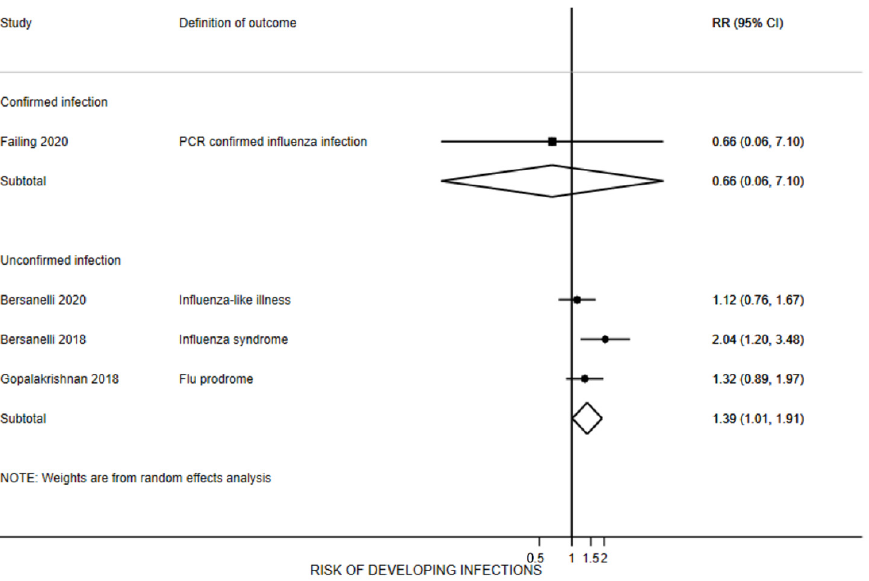
Figure 5. Risk of developing an influenza infection in patients receiving immune checkpoint inhibitors after vaccination compared with unvaccinated patients.